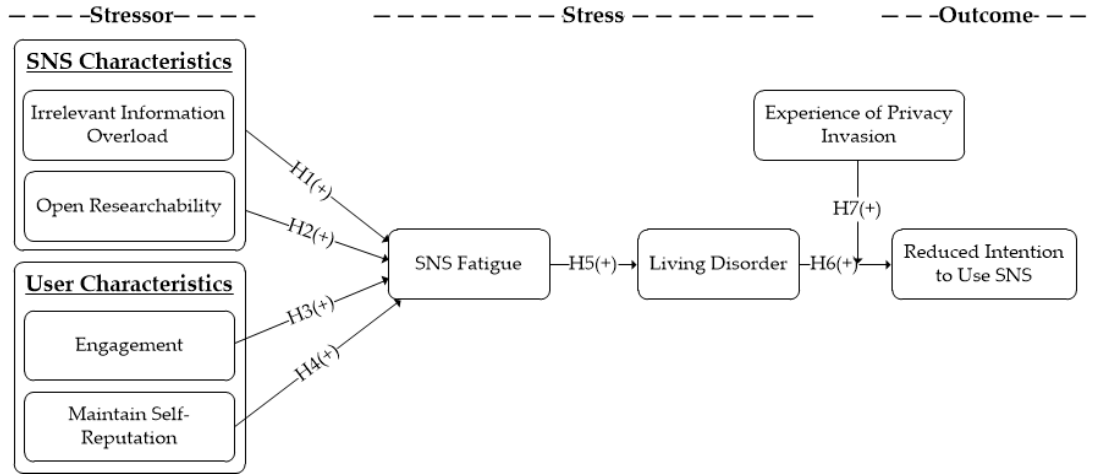
Figure 2. Research model with hypotheses.